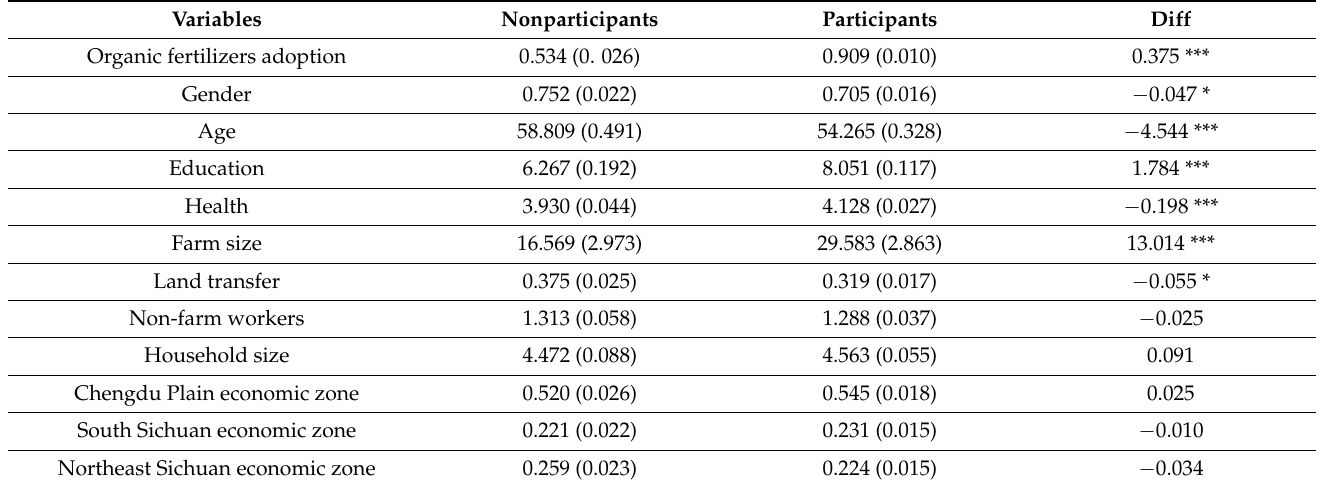
Table 2. Mean difference in characteristics between participants and nonparticipants of the technical training provided by agricultural